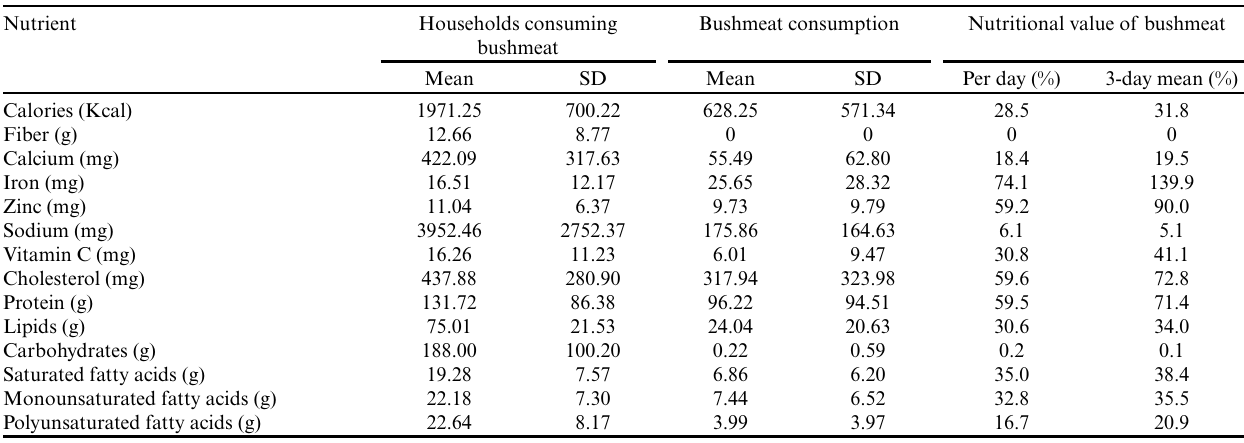
Table 5. Comparison of nutrient intake from bushmeat per meal per day in relation to nutritional value of the meal and usual daily household